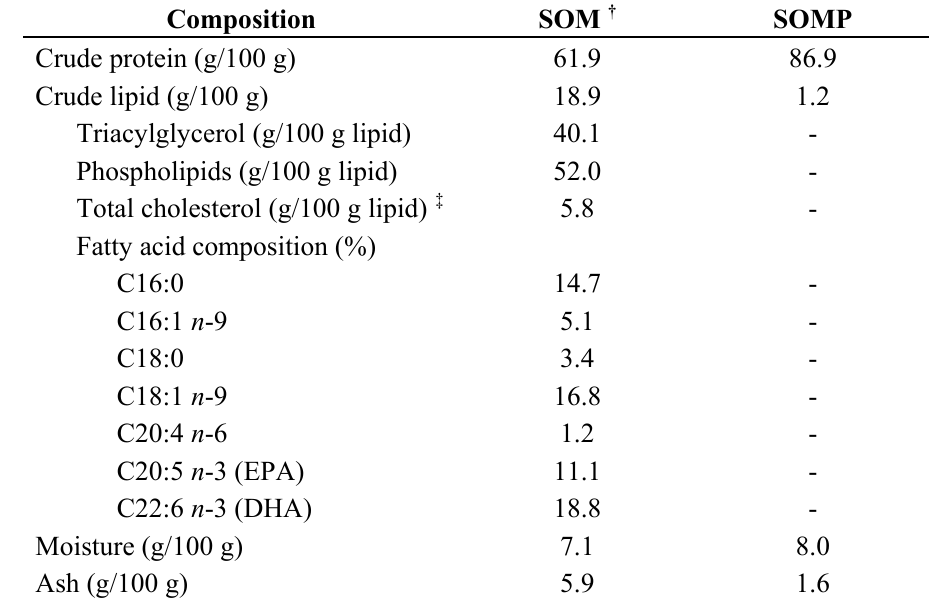
Table 2. Chemical composition of salmon ovary outer membrane (SOM) and salmon ovary outer membrane protein